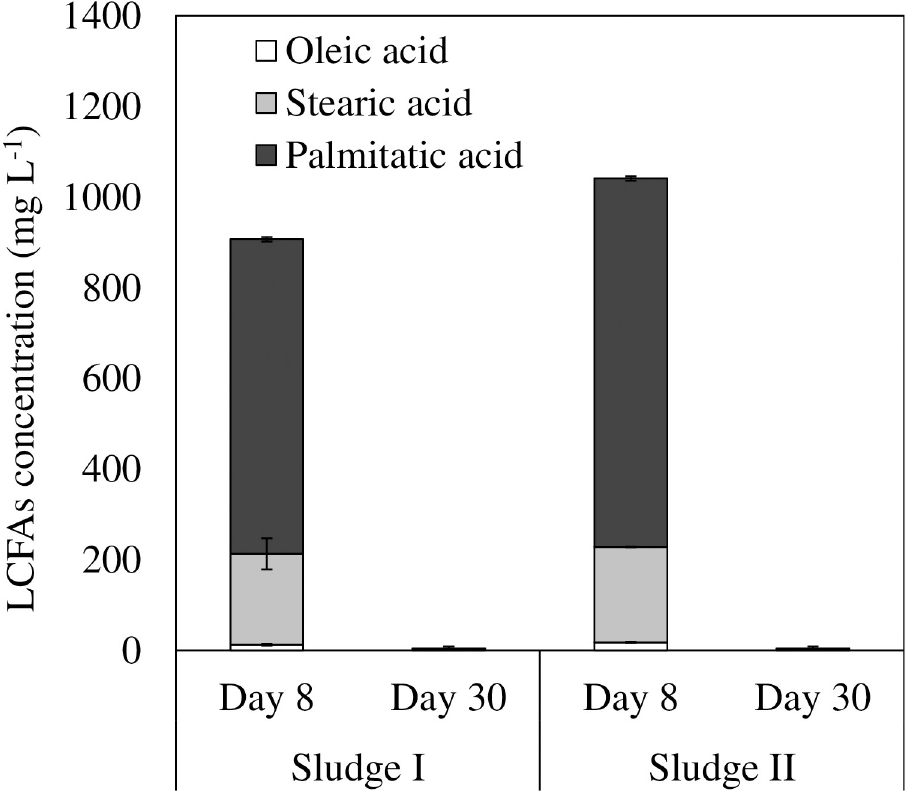
Fig 3. The LCFAs concentration in each reactor. Error bars represent the standard deviation of the mean (n = 3).